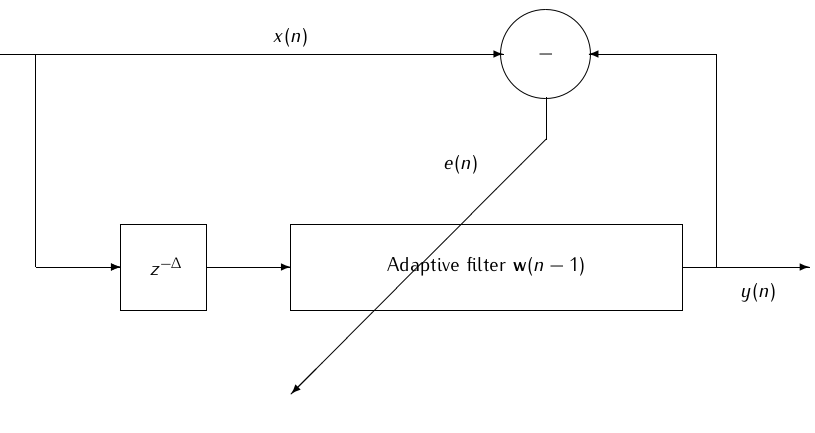
Figure 2. The adaptive line